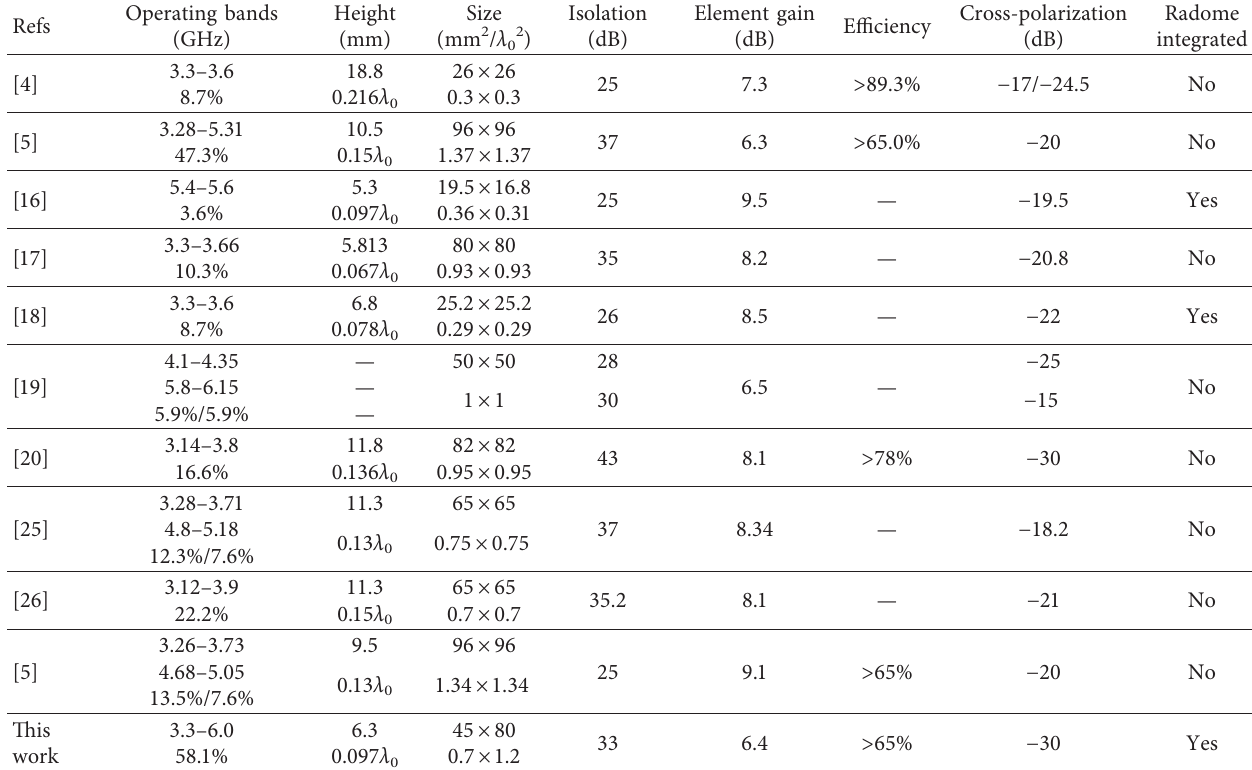
Table 2: Comparison of the proposed antenna array with previous